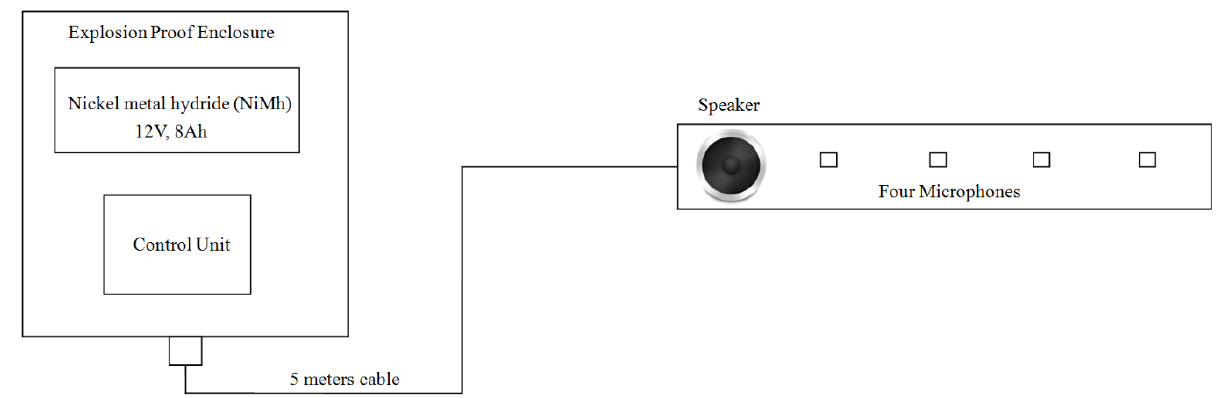
Figure 11. Schematic diagram of the acoustic sensor in the chamber.